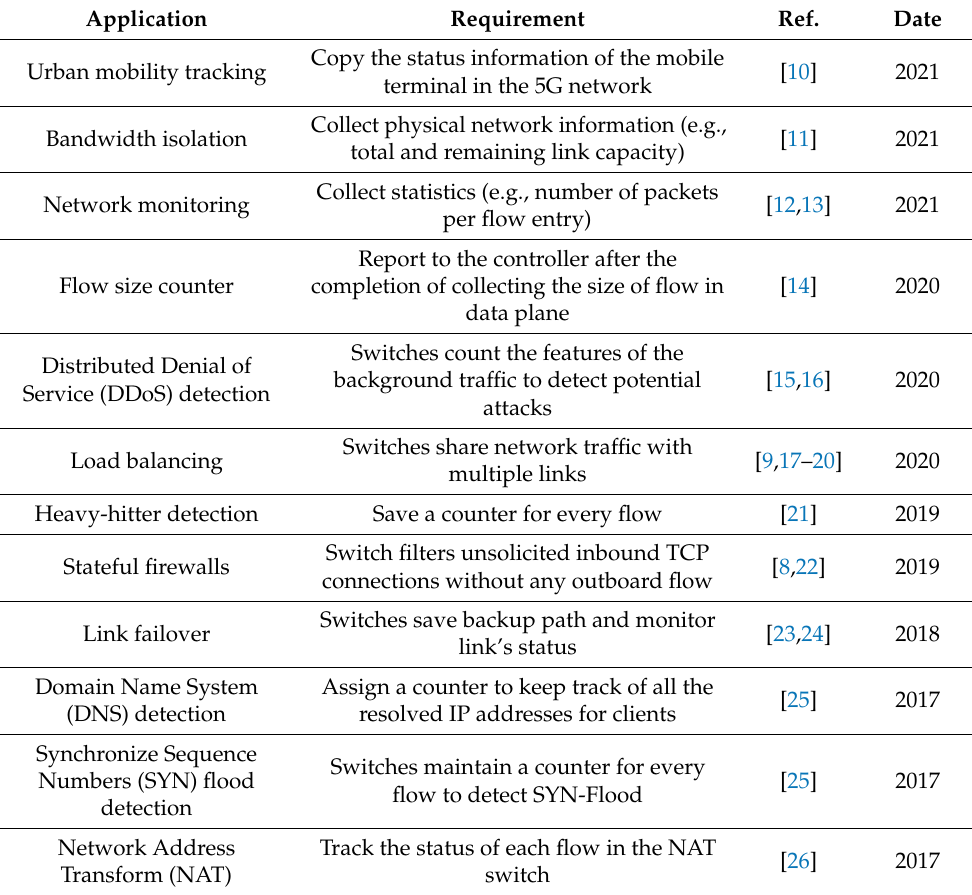
Table 1. Applications that need network status handling on the data